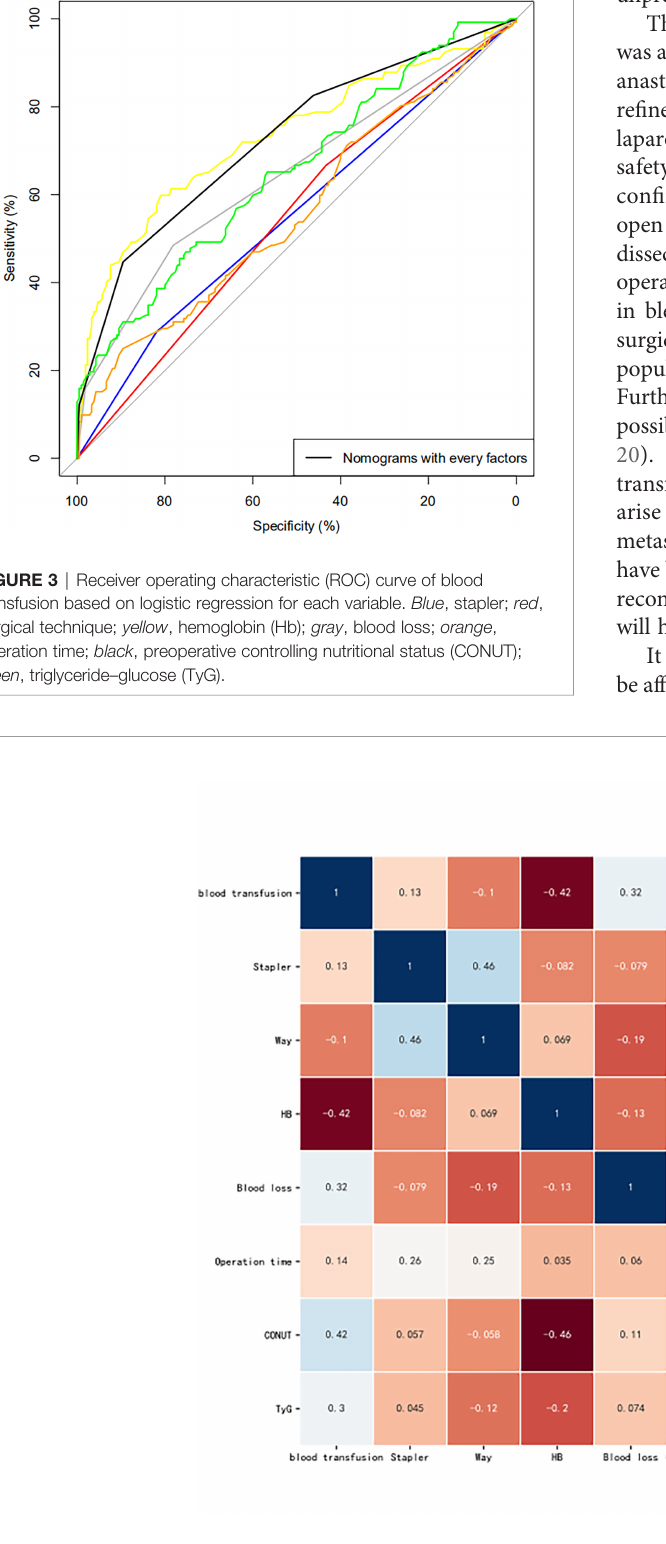
FIGURE 4 | Correlation between